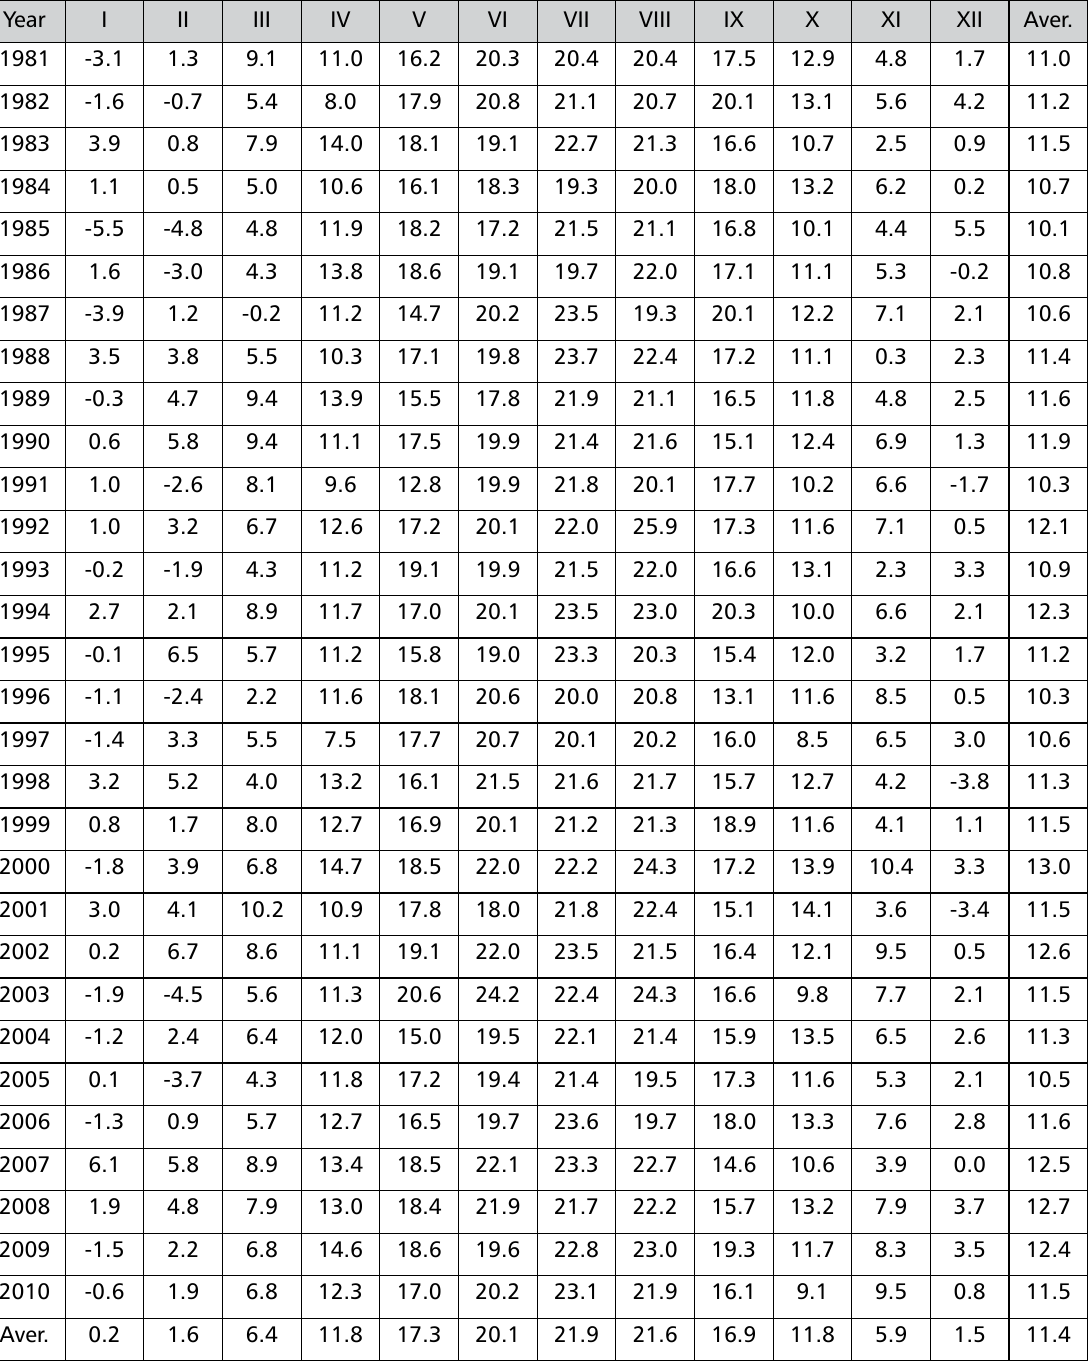
The average monthly and annual air temperatures in Bačka Palanka area (°C), over the period